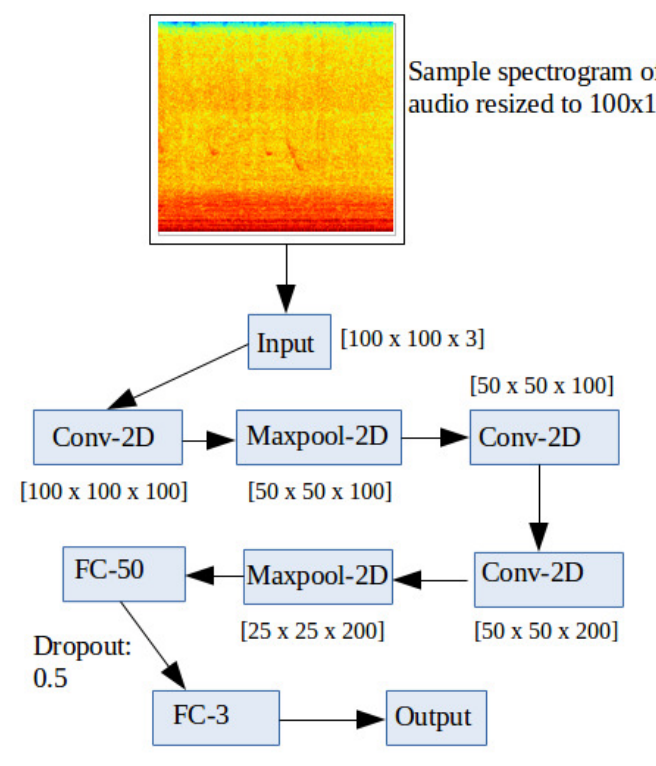
Figure 5. SpectConvNet Architecture. The numbers below each box, except for the input, denote the dimensions of the resultant feature map following the corresponding operation in the box.